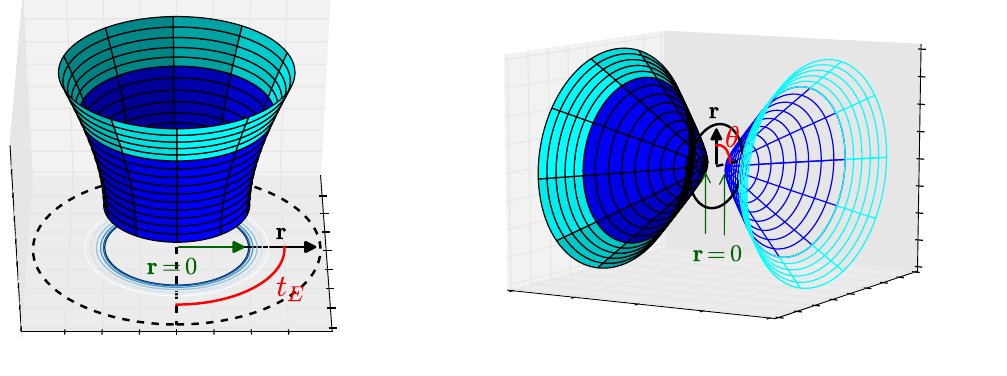
Figure 6 . Euclidean manifold for thermal AdS. Light/dark blue respectively refers to out- side/inside the shell. Left: Euclidean time vs radius plane embedded in a higher dimension. The manifold reaches r = 0 which is similar to flat space. Right: angular vs radius plane with one angular coordinate suppressed. There is no throat connecting both sides but they are connected through the Euclidean